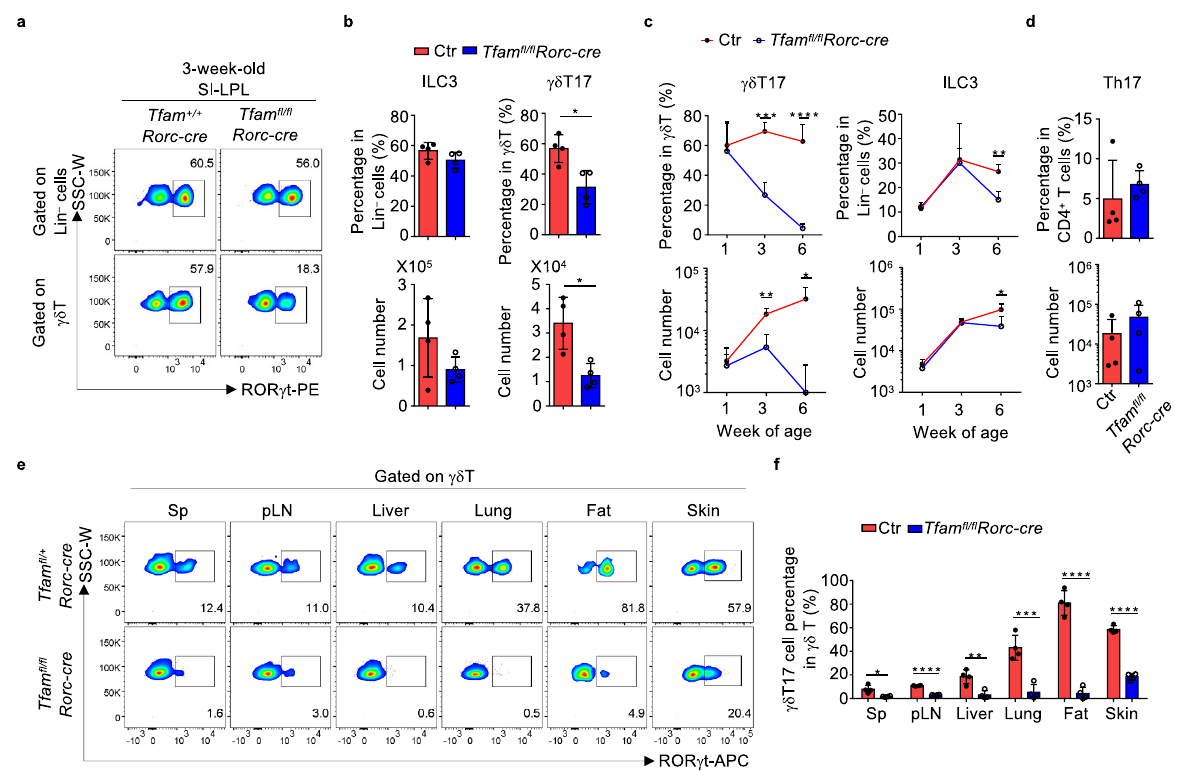
Fig. 2 Tfam is critical for γδ T17 cell and ILC3 maintenance. a Flow cytometry analyses of ILC3s (upper panel, gated on lineage-negative lymphocytes) and γδ T17 cells (lower panel, gated on γδ T cells) from small intestine lamina propria (LPL) of 3-week-old mice of indicated genotypes. Representative data of three independent experiments. Lineage markers in b and c include CD3, CD5, CD19, Ly6G, CD11b, and CD11c. b γδ T17 cell percentages in total γδ T cells (percentage, * P = 0.0120; cell number, * P = 0.0106), and ILC3 percentages in lineage-negative (Lin – ) cells (upper panel) ( P = 0.1575) and cell numbers (lower panel) ( P = 0.1725) from the small intestine of mice shown in a ( n = 4 for each group). Compiled data from two independent experiments. c γδ T17 cell percentages in total γδ T cells and ILC3 percentage in lineage-negative cells (upper panel) ( γδ T17: week 3, *** P = 0.0002, week 6, **** P < 0.0001; ILC3: week 6, ** P = 0.0019) and cell numbers (lower panel) ( γδ T17: week 3, ** P = 0.0035, week 6, * P = 0.0101; ILC3: week 6, * P = 0.0396) of the large intestine of mice at indicated ages ( n = 4 for each group). The rest time points showed no signi fi cance between Ctr and Tfam fl / fl Rorc-cre ( P > 0.05). Compiled data from two independent experiments. d Th17 cell percentages in total CD4 + T cells (upper panel) ( P = 0.1705) and cell numbers (lower panel) ( P = 0.0950) of the large intestine of 6-week-old age mice ( n = 4 for each group). Compiled data from two independent experiments. e ROR γ t expression in γδ T cells of various organs (Sp spleen, pLN peripheral lymph nodes) of mice with indicated genotypes measured by fl ow cytometry. Representative data of three independent experiments. f γδ T17 cell percentages in total γδ T cells from the various organs as shown in e ( n = 4 for each group). Sp, * P = 0.0121; pLN, **** P < 0.0001; liver, ** P = 0.0043; lung, *** P = 0.0009; fat, **** P < 0.0001; skin, **** P < 0.0001. Compiled data from two independent experiments. Ctr included Tfam + / + , Tfam fl / + , Tfam fl / fl , Tfam + / + Rorc-cre , and Tfam fl / + Rorc-cre mice. Data are shown as mean ± SD in b – d , f